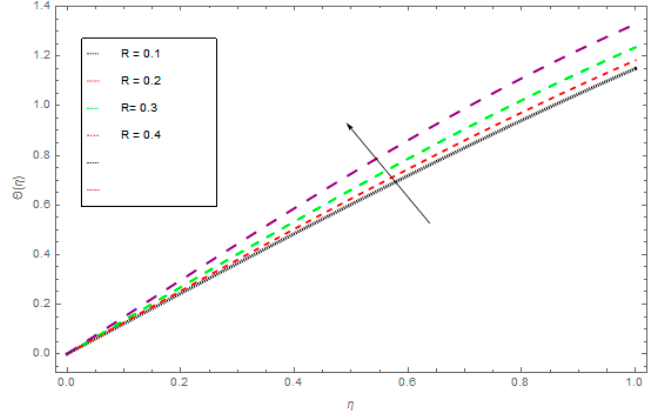
Figure 6. The influence of Pr on θ ( η ) when Ω = 1, ρ = 1, σ = 0.5, k = 1, M = 1.